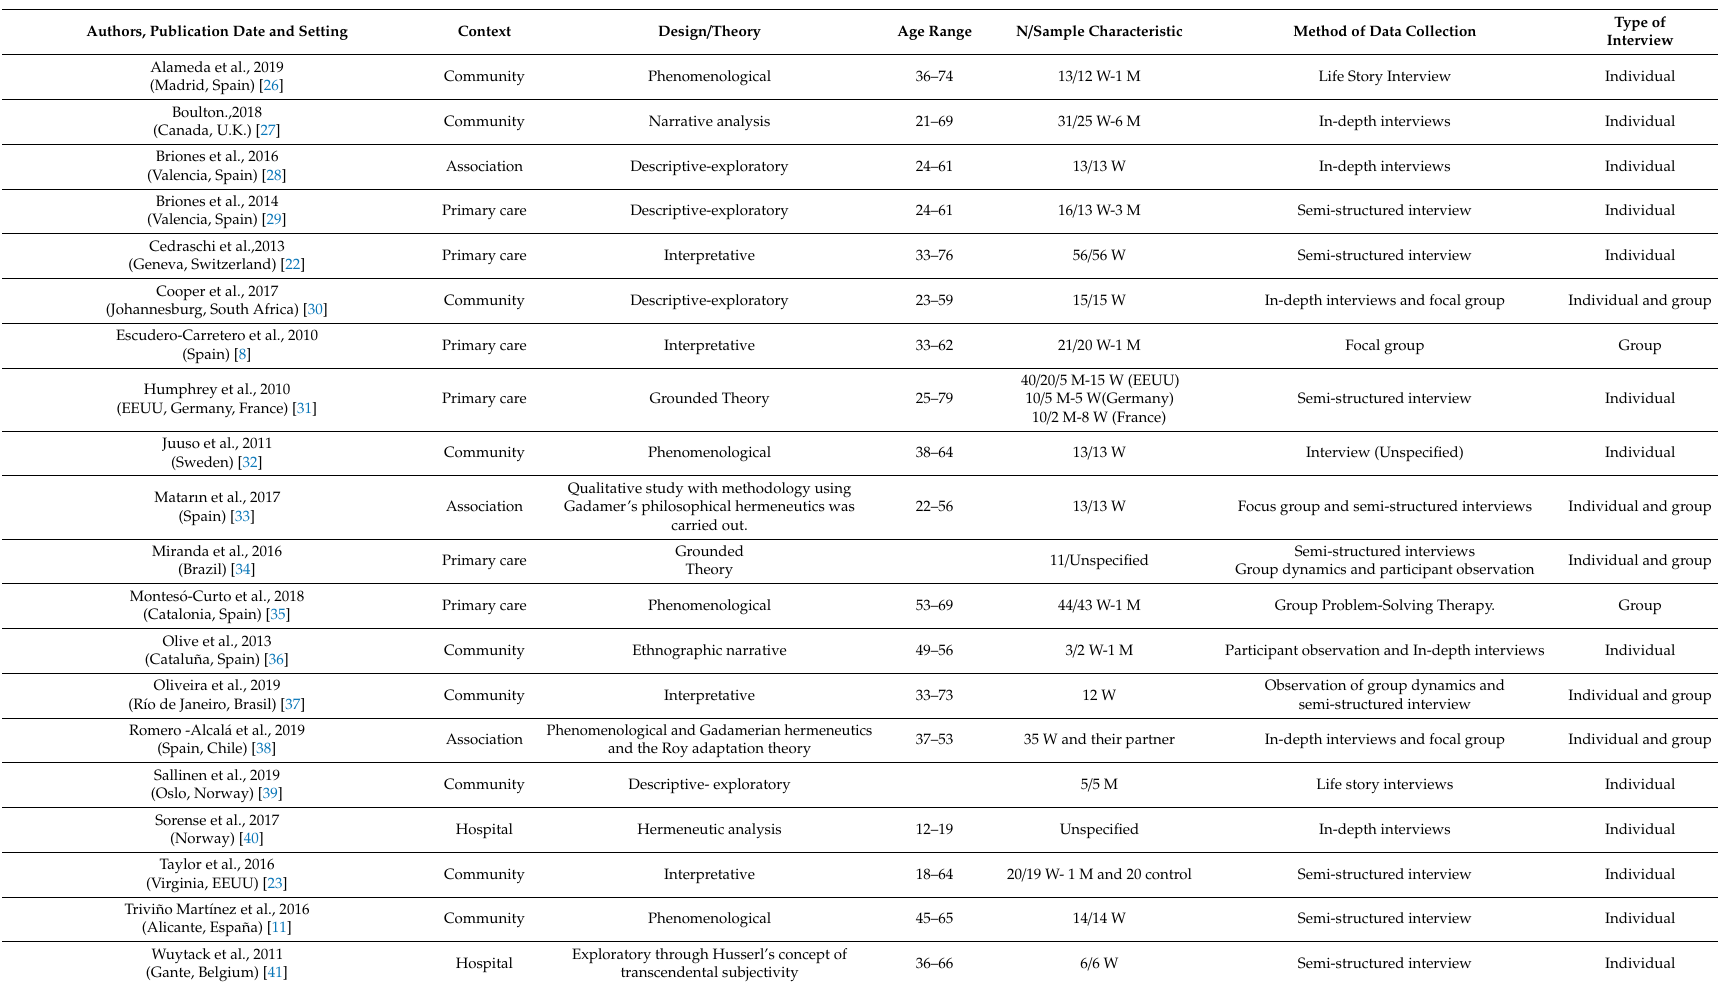
Table 1. Summary of studies included in the